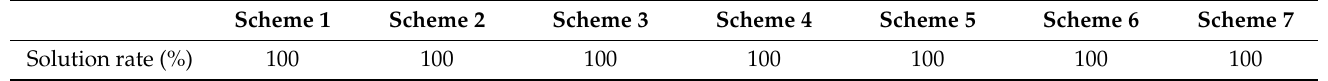
Table 1. The solution rate of the seven schemes for the static data.